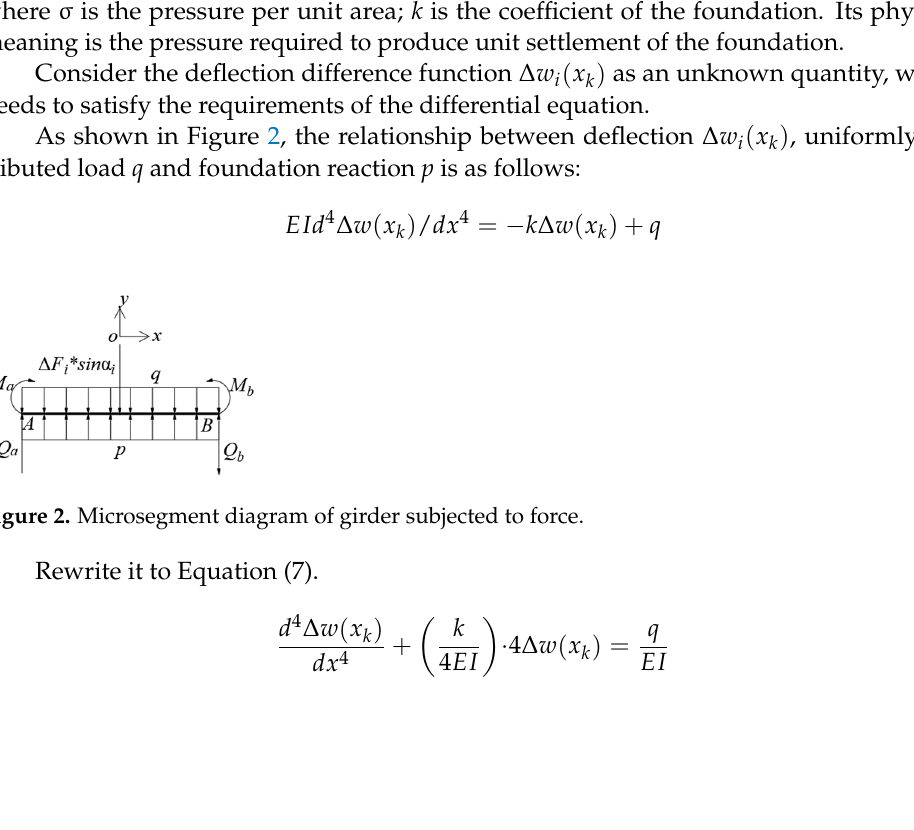
Figure 1. Stress analysis diagram of the girder section: ( a ) Stress state of beam AB in the healthy state; ( b ) Stress state of beam AB after cable damage.